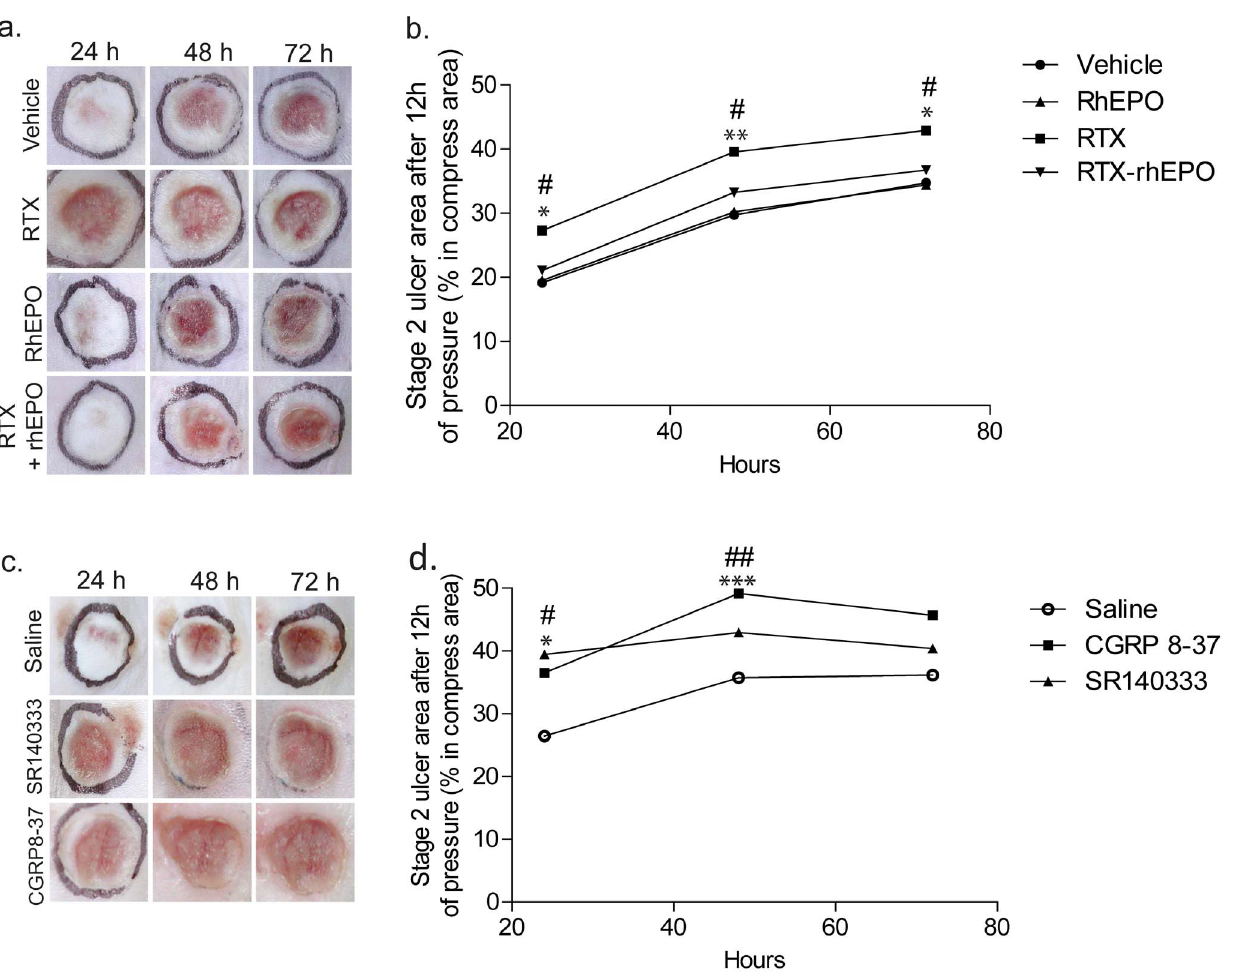
Figure 5. Cutaneous macroscopic findings following 12 h of pressure ( a,b ). Effect of RTX and rhEPO. (a) Macroscopic appearance of pressure-ulcers (PUs) 24 h, 48 h and 72 h after pressure release. (b) Time course of macroscopic stage 2 PU areas. n 5 20 in each group, non-parametric Kruskal-Wallis test followed by Dunn’s multiple comparisons test * p , 0.05, ** p , 0.01 Vehicle vs. RTX, # p , 0.05 RTX vs. RTX-rhEPO. ( c,d ) Effect of SR140333 (NK1 antagonist) and CGRP 8-37 (CGRP antagonist) (c) Macroscopic appearance of pressure-ulcers (PUs) 24 h, 48 h and 72 h after pressure release. (d) Time course of macroscopic stage 2 PU areas. n 5 10 in each group,non-parametric Kruskal-Wallis test followed by Dunn’s multiple comparisons test, * p , 0.05, *** p , 0.001, CGRP 8-37 vs. Saline mice. # p , 0.05, SR140333 vs. Saline mice. rhEPO: recombinant human erythropoietin, RTX: